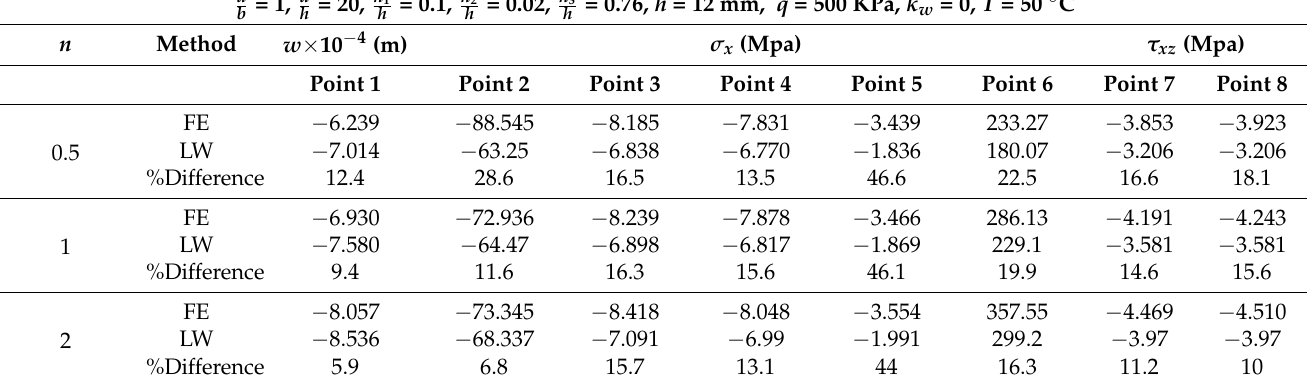
Table 8. Comparison of the result based on LT and those FE